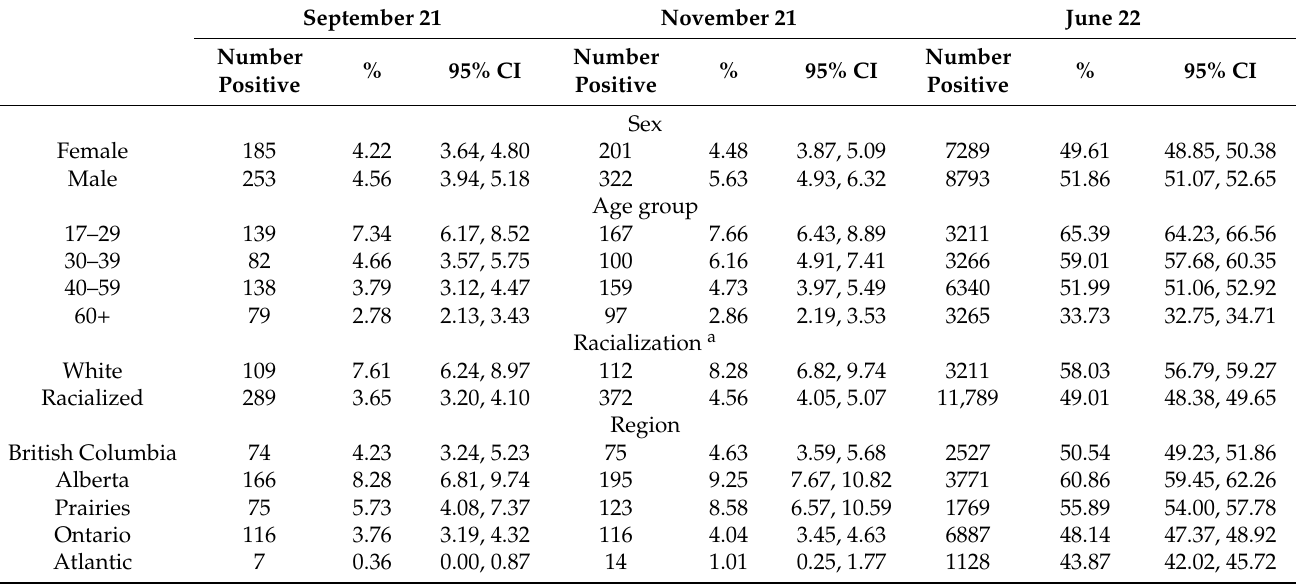
Table A3. The number of samples anti-N positive with the percentage and 95% confidence